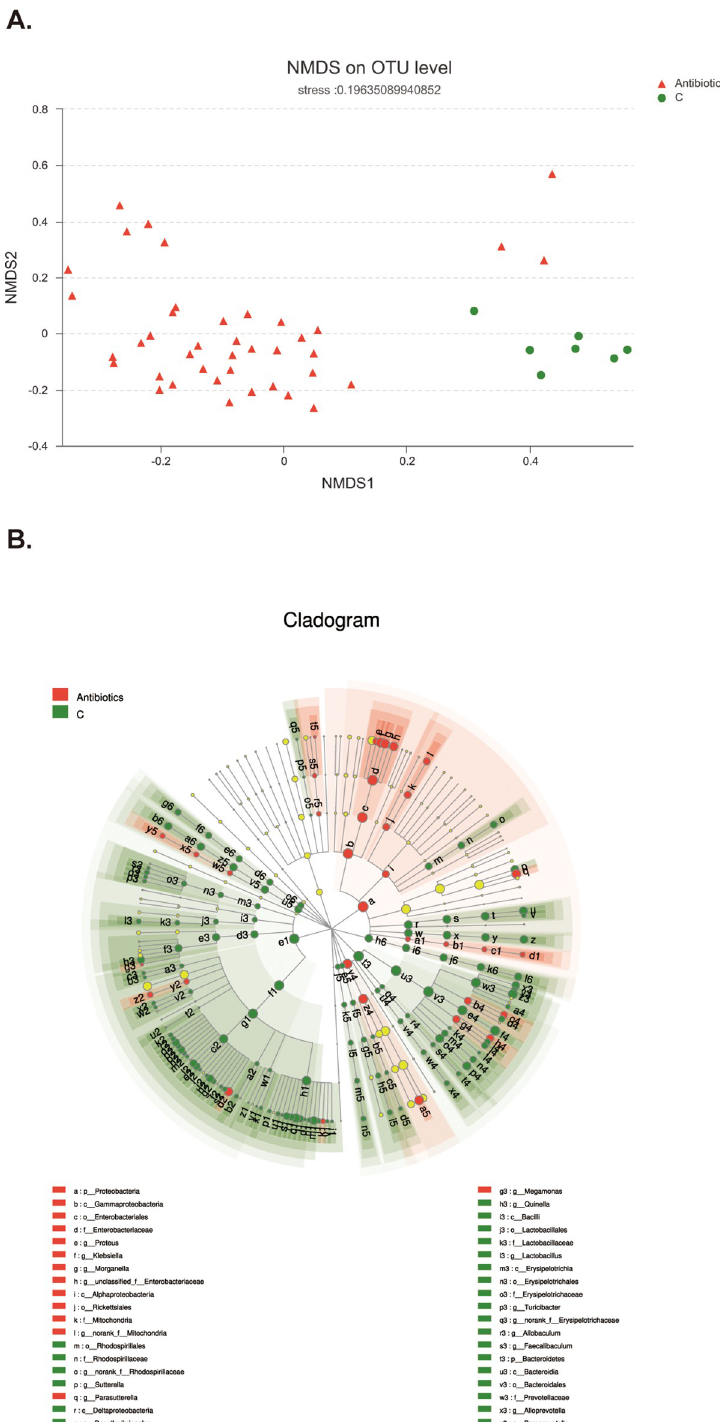
Fig 2. NMDS and LEfSe analysis of intestinal microbiota composition after antibiotics treatment. A. The green dots, representing the distributions of samples in control group, mainly distribute at the lower right area. The red triangles, standing for samples of antibiotics group, locate at the left area. B. Green symbolizes the differential bacteria in control group, and red stands for bacteria with significant difference in antibiotics group. Species with in-apparent variation are represented by yellow dot. The circle is segmented into five layers, respectively representing phylum, class, order, family, and genus levels from the inside out.